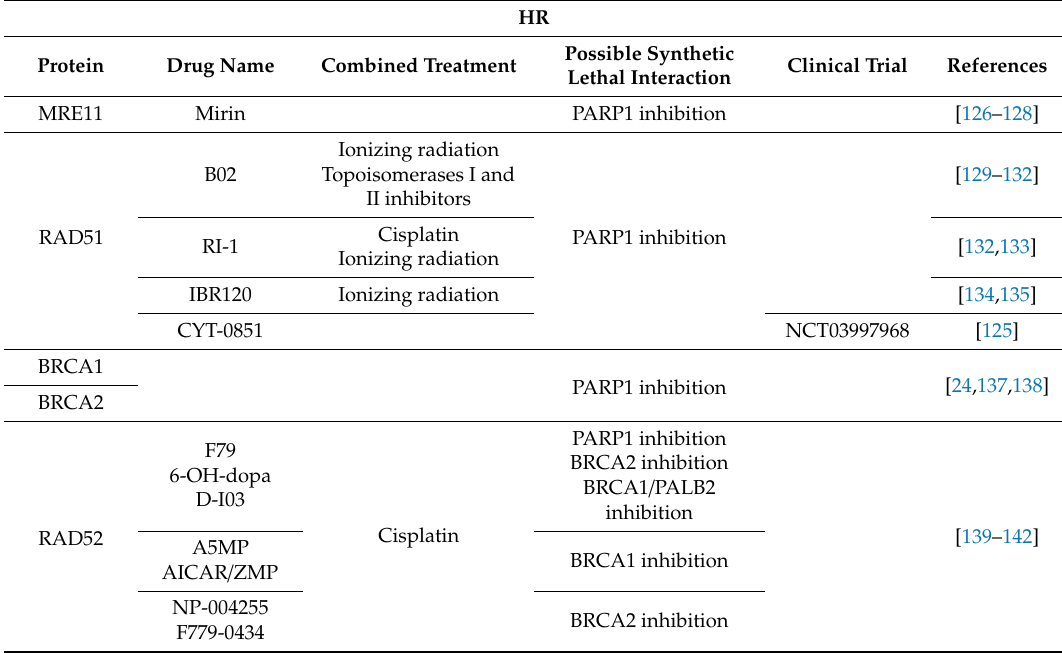
Table 2. HR repair proteins targeted in cancer